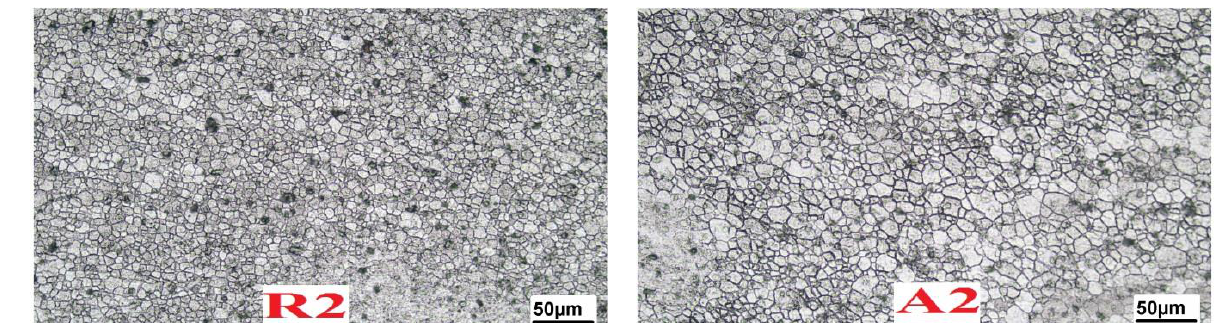
Materials 2021 , 14 , x FOR PEER REVIEW Figure 14. Distribution of SZ microstructure for welded specimens using AP-FSW and RP-FSW techniques.